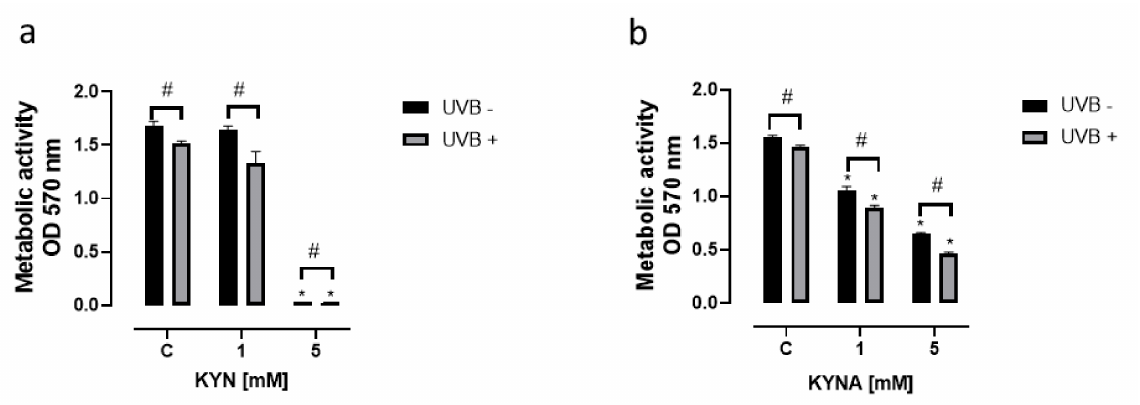
Figure 4. The effect of UVB on the metabolic activity of melanoma SK-MEL-3 cells exposed to KYN ( a ) and KYNA ( b ). Melanoma SK-MEL-3 cells were exposed to UVB (UVB+) and then to culture medium (control, C) or serial dilutions of KYN and KYNA (1 and 5 mM) for 96 h. Similarly, the biological activity of KYN and KYNA was studied in melanoma cells under standard conditions (UVB − ). The effect of UVB and tested substances on the metabolic activity of melanoma SK-MEL-3 cells was assessed by the MTT Assay. Data represent the mean value ± SEM of eight independent experiments. Values significant (*) in comparison with appropriate control (UVB − or UVB+) with p < 0.05 (one-way ANOVA with Tukey’s post hoc test). Values significant (#) UVB − vs. UVB+ with p < 0.05 (unpaired t